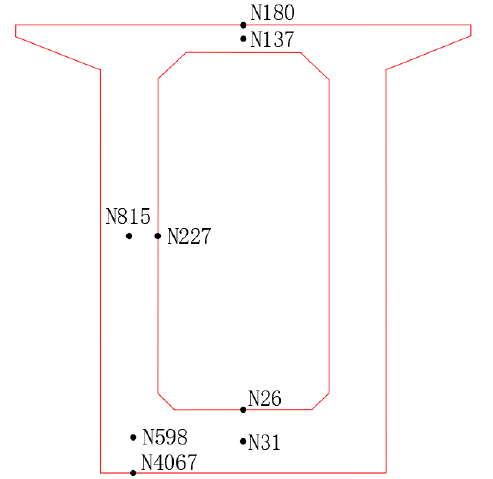
Figure 2. Location and quantity of temperature-measuring points in the mid-span section.